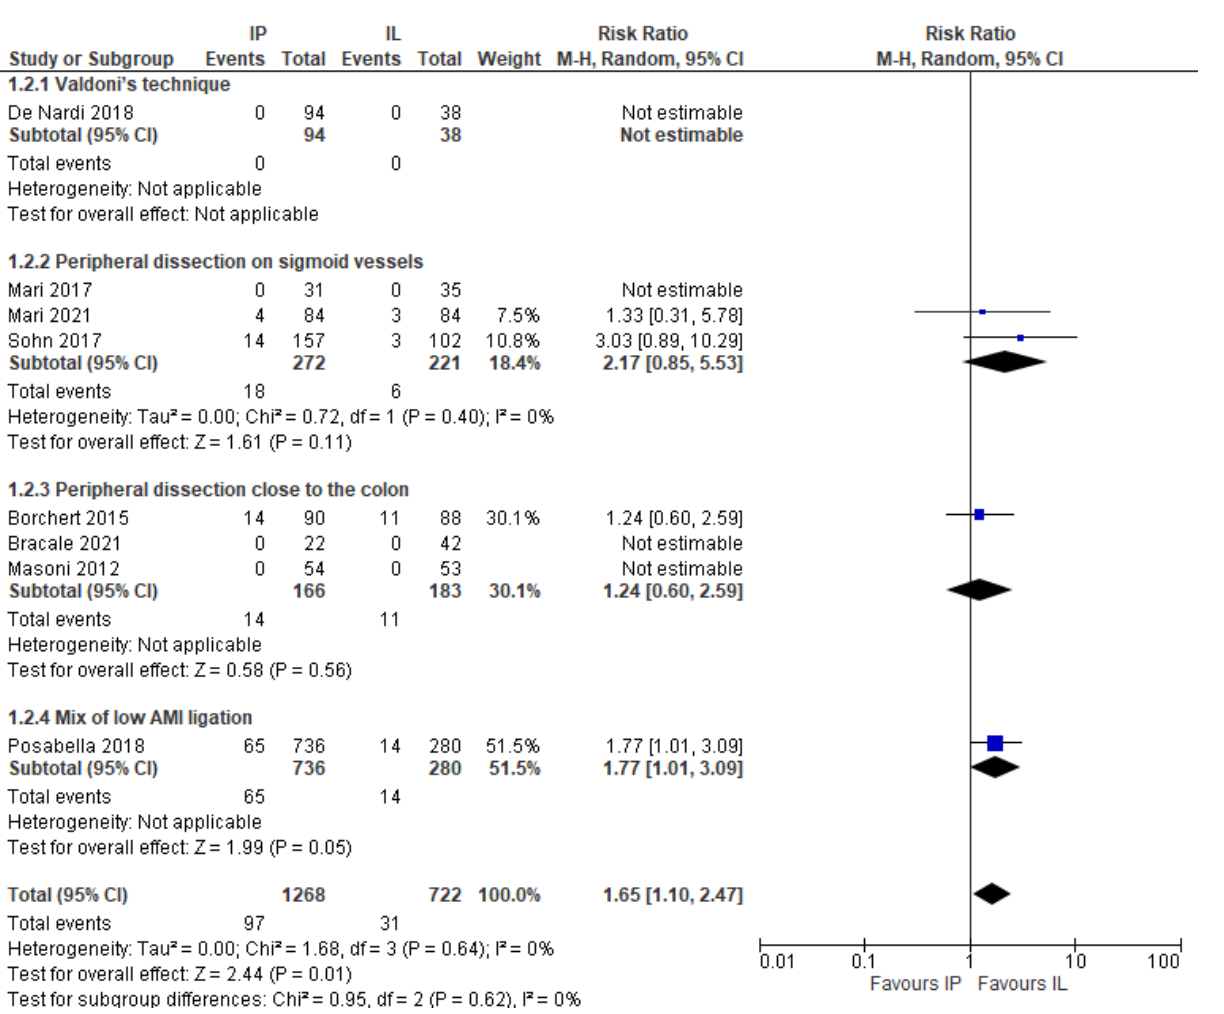
Figure 11. Conversion rate, risk ratio in the laparoscopic subgroup according to different technique for IMA preservation.